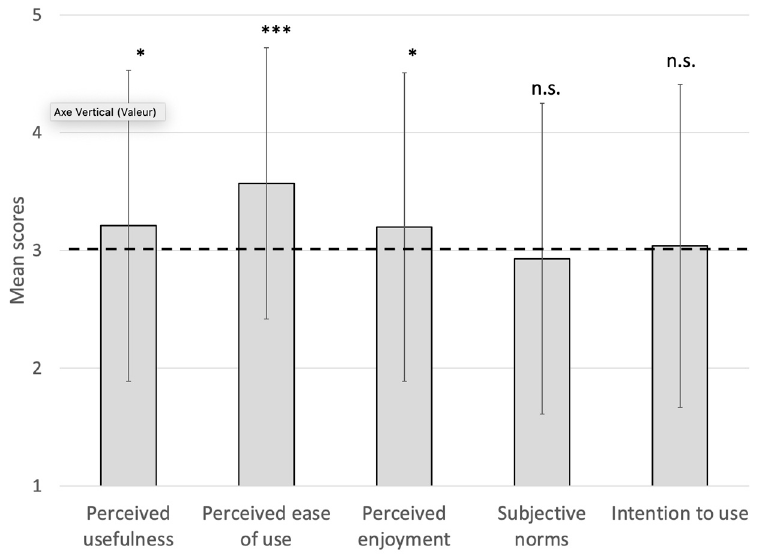
Figure 3. Comparison with the mean of the scale for each variable of the TAM. The dotted line represents the mean of the scale. * p < 0.05, *** p < 0.001, n.s. = non-significant.